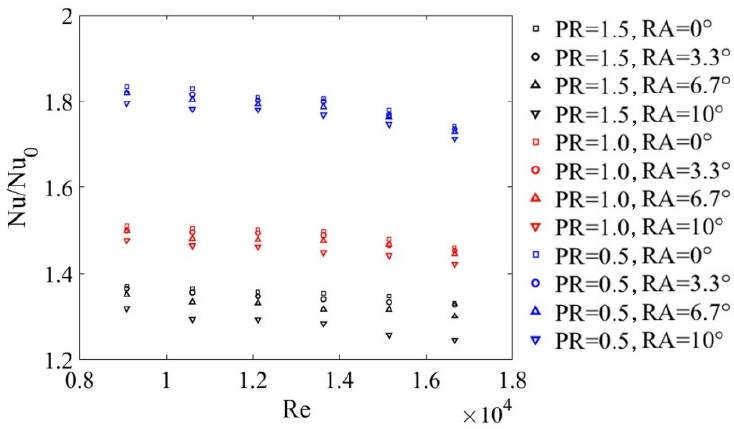
Figure 8. The distributions of ( a ) 𝑊 (cid:3030)(cid:3052) /∆𝑇 , ( b ) 𝑊 (cid:3032)(cid:3052) /∆𝑇 , ( c ) (𝑊 (cid:3030)(cid:3052) + 𝑊 (cid:3032)(cid:3052) )/∆𝑇 , ( d ) 𝑞 (cid:3052) /∆𝑇 on the lines inspected. In addition, the Nusselt number ratios ( 𝑁𝑢 𝑁𝑢 augmentation of the tube’s 𝑁𝑢 values with the insertion of the DWPVGs, where 𝑁𝑢 was obtained from the smooth tube. Figure 9 showss that the values of 𝑁𝑢 𝑁𝑢 creased slightly with increasing 𝑅𝑒 numbers.